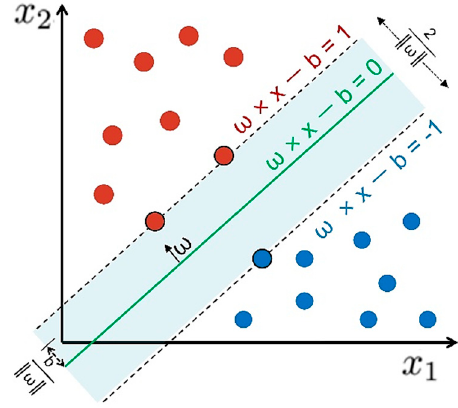
Figure 6. Conceptual principle of the SVM.